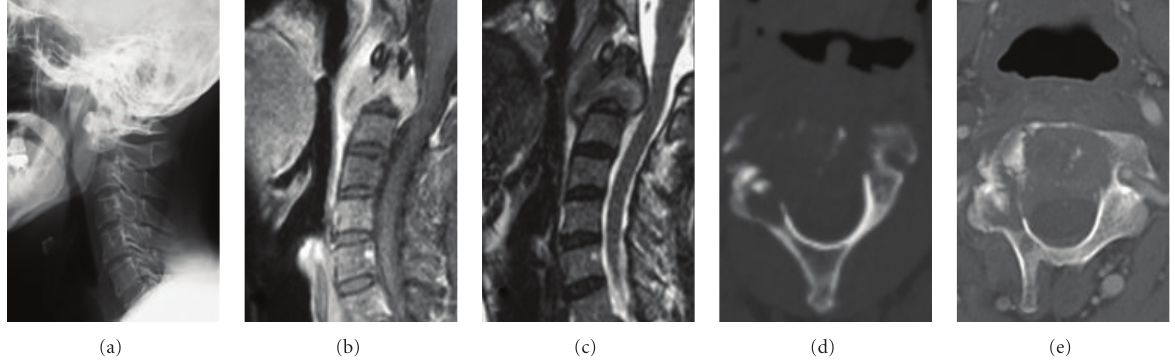
Figure 1: (a) Lateral radiograph showing irregular osteolysis at the anterior part of C2. Magnetic resonance (MR) imaging ((b) T1-weighted and fat suppression sagittal image with gadolinium enhancement, (c) T2-weighted sagittal image) showing a mass lesion at C2, which has marked enhancement after intravenous injection of gadolinium-DTPA. (d), (e) Axial image of computed tomography (CT) at the level of C2 showing irregular osteolysis at the anterior part of C2 and thickening of the posterior pharyngeal wall. ((d) CT for radiation therapy planning, (e) CT postradiation therapy with intravenous injection of